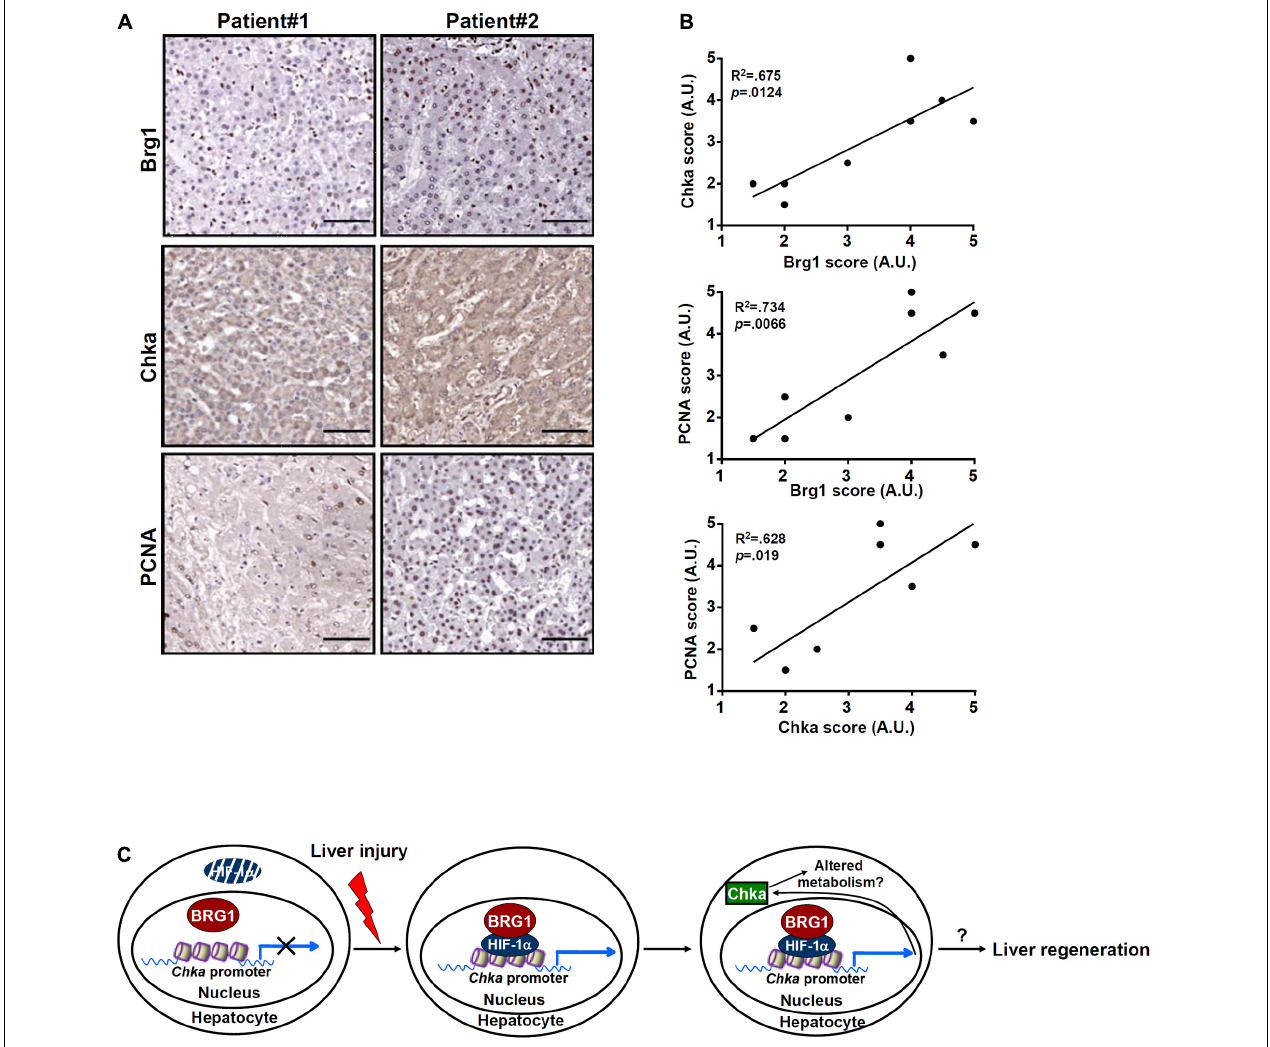
FIGURE 6 | Choline kinase alpha expression correlates with Brg1 expression in ALF patients. (A) Paraffin sections of liver specimens collected from patients with acute liver failure were stained with anti-CHKA and anti-Brg1. N = 8 cases. (B) Linear regression was performed with GraphPad Prism. (C) A schematic model. Under physiological conditions, HIF-1 α proteins are constantly degraded in hepatocytes presumably by the ubiquitin–proteasome system and Chka transcription is turned off. Exposed to injurious stimuli, HIF-1 α proteins become stabilized and recruit BRG1 to activate Chka transcription. Elevated Chka levels may alter cellular metabolism and promote proliferation of hepatocytes eventually leading to liver